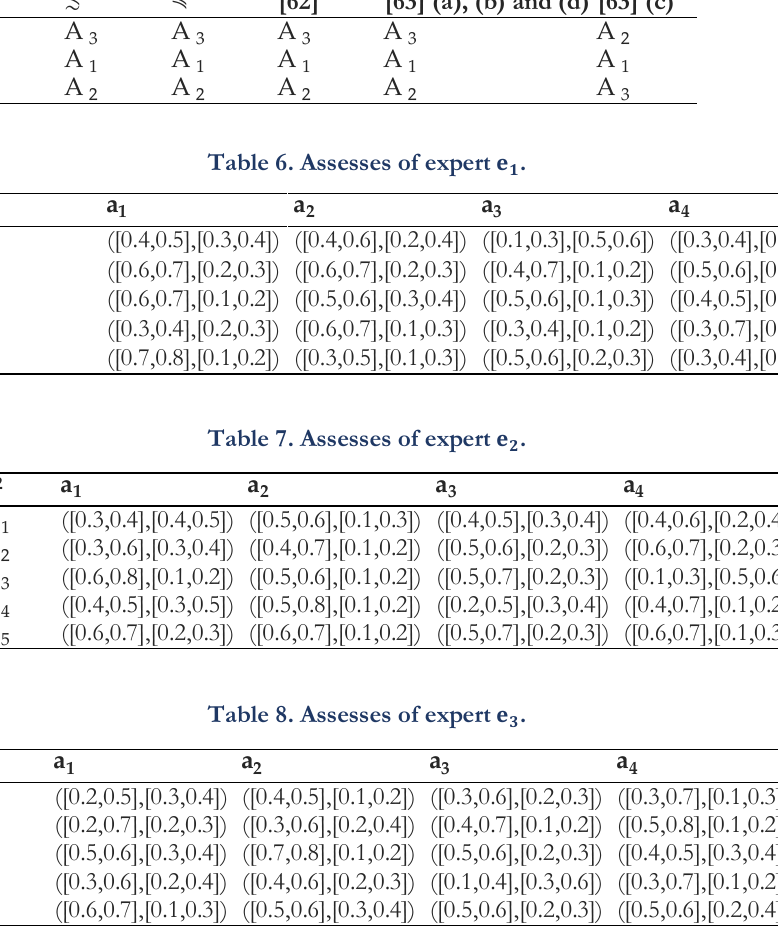
Table 5. Ranking obtained for the alternatives considering several total orders and the obtained in [62], [63].